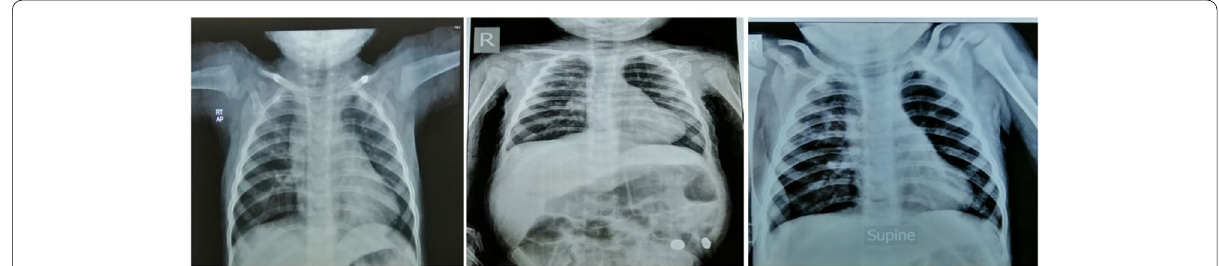
Fig. 1 Plain chest radiographic examination showing patchy infiltrates in the